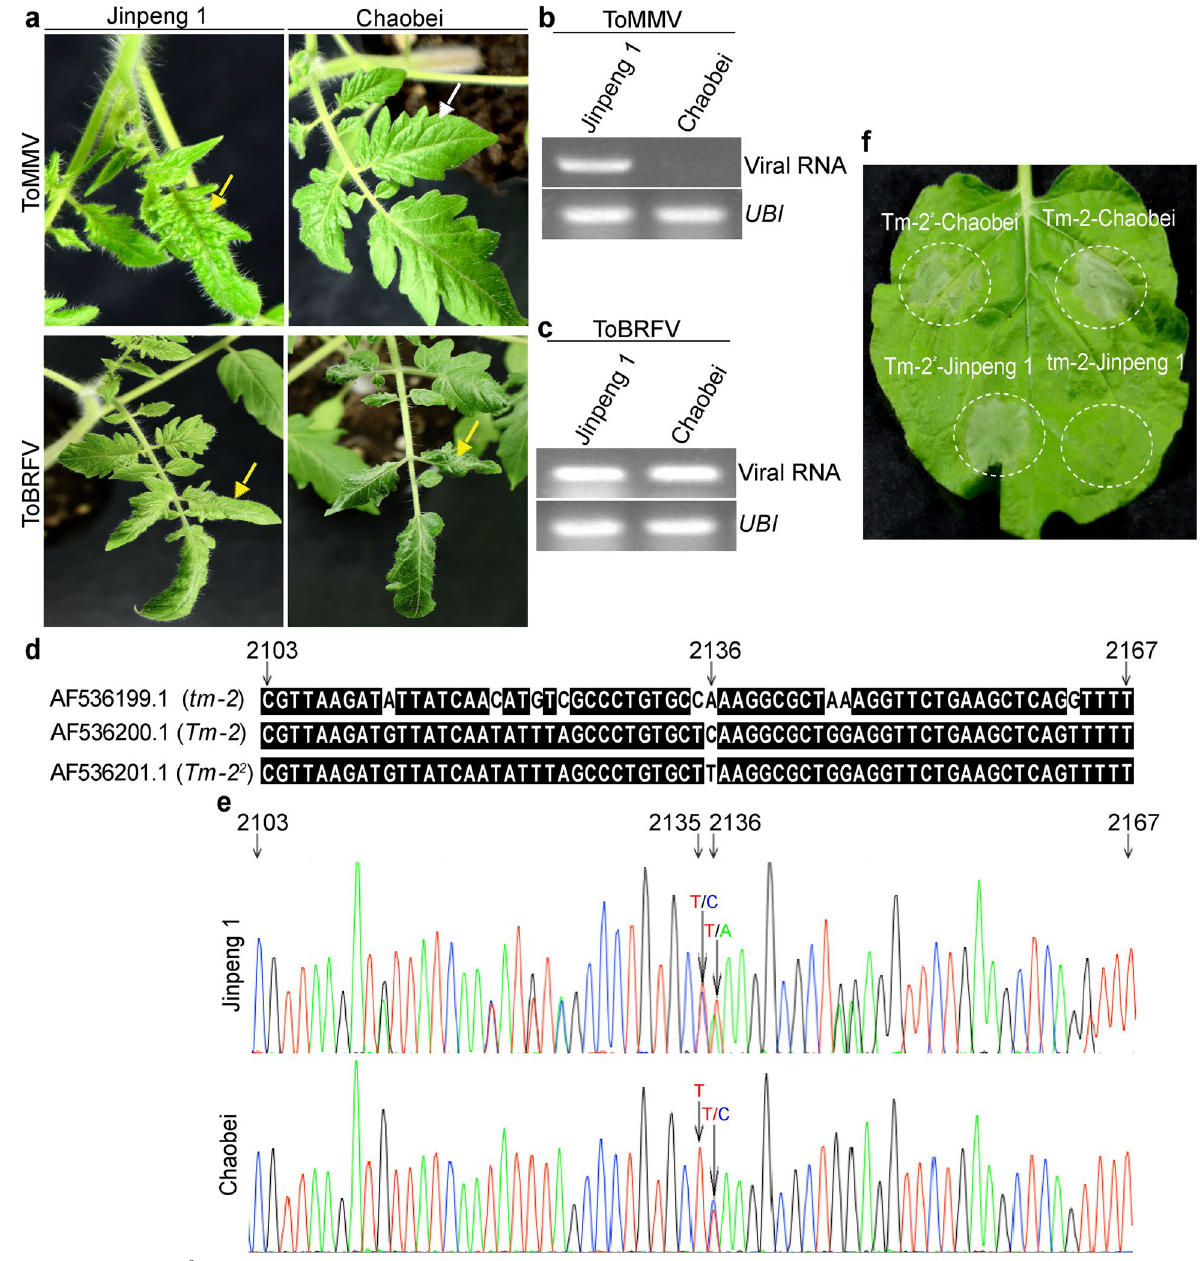
Fig. 3 Effect of Tm-2 2 allele composition of tomato cultivars on the disease resistance against ToMMV. a The symptoms of systemic leaves of tomato cultivars Jinpeng 1 ( Tm-2 2 /tm-2 ) and Chaobei ( Tm-2 2 /Tm-2 ) inoculated with ToMMV or ToBRFV at 14 days post‑agro‑infiltration. b , c RT‑PCR analysis of ToMMV and ToBRFV RNA in the systemic leaves of tomato cultivars Jinpeng 1 and Chaobei. UBI gene was used as an internal control. This experiment was repeated three times. d Alignment of partial coding sequences of tm-2 (accession number; AF536199.1), Tm-2 (accession number; AF536200.1), and Tm-2 2 (accession number; AF536201.1). e Sequence chromatogram showing the allele composition of tomato cultivars Jinpeng 1 and Chaobei. f Hypersensitive response‑associated cell death in wild‑type Nicotiana benthamiana leaves co‑expressed with ToMMV MP and Tm-2 2 , Tm-2 , or tm-2 . Tm‑2 2 ‑Chaobei and Tm‑2‑Chaobei were derived from Chaobei tomato and Tm‑2 2 ‑Jinpeng 1 or tm‑2‑Jinpeng 1 was derived from Jinpeng 1 tomato. The picture was taken at 48 h post‑agro‑infiltration. Yellow arrows show symptomatic systemic leaves and white arrows show asymptomatic systemic